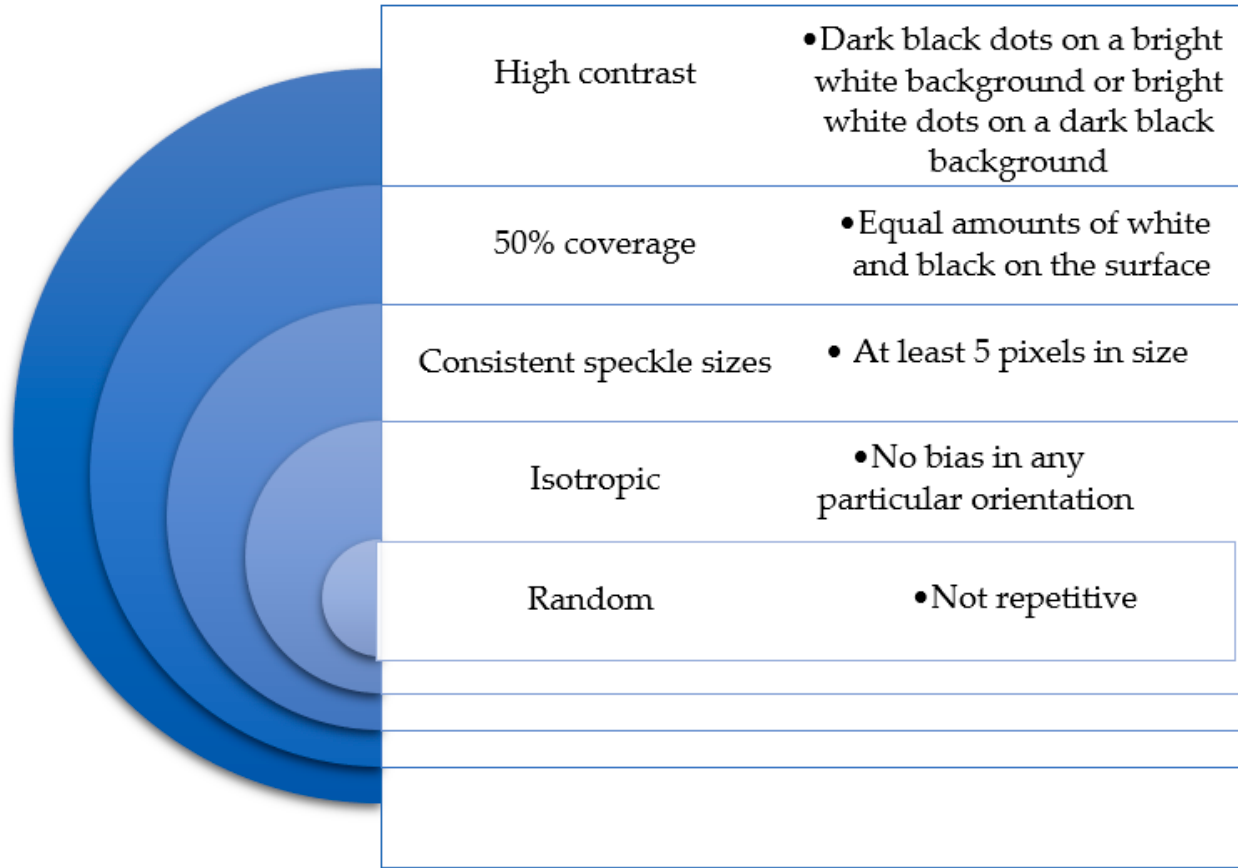
Figure 3. General pattern requirements for the DIC method (according to recommendations in [62]).